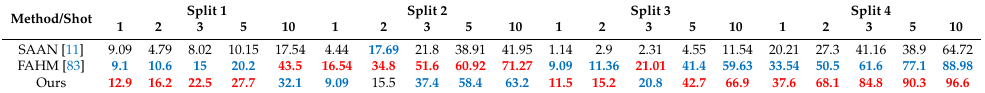
Table 7. FSOD performance (AP50 in %) on the novel classes of the RSOD dataset . Random one class is selected as the novel class and the remaining classes are base ones. Red and blue refer to the state-of-the-art and the second best. SAAN and FAHM are both meta-learning-based few-shot detectors. Our methods are based on transfer learning.